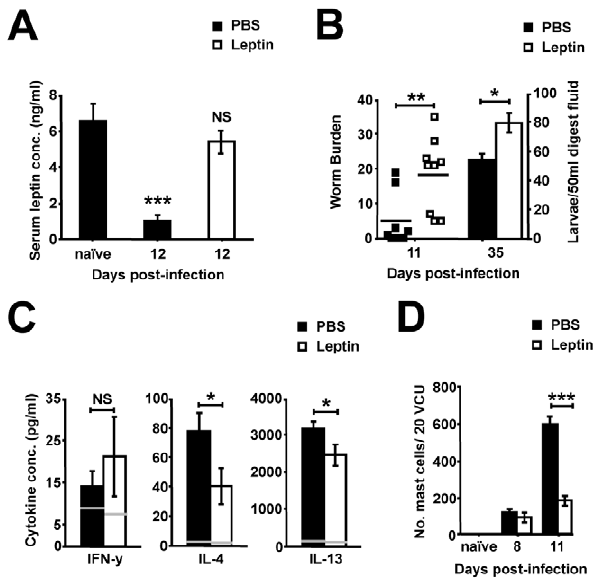
Figure 5. The maintenance of basal leptin levels during T. spiralis infection results in delayed parasite expulsion. ( A ) Serum leptin levels in PBS and leptin treated mice, determined via ELISA. ( B ) Adult and larval worm burdens in infected mice. ( C ) IFN-y, IL-4 and IL-13 cytokine levels from Ag-specific re-stimulation of day 8 p.i. mLN cells from PBS and leptin treated mice, grey lines represent naı¨ve levels; determined via cytometric bead array. ( D ) Mast cells/20 VCU in PBS and leptin treated mice; accessed via toludine blue staining. Data (n=9 mice per group) are from two independent experiments. *, P , 0.05; **, P , 0.01; or ***, P , 0.005 between naı¨ve and infected groups or for indicated comparisons, error bars represent SE of means.